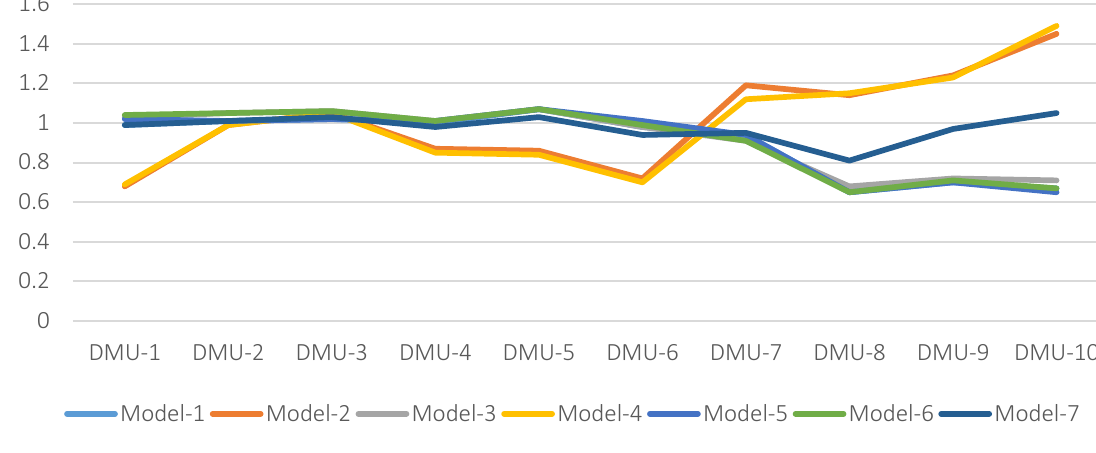
Figure 1. Change in efficiency of Saudi Arabian banks Table 6. The scores of technical changes in the efficiency of Saudi Arabian banks